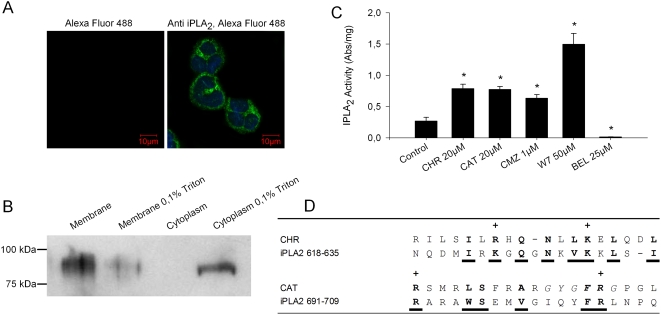
CHR and CAT stimulate iPLA2 activity.A) Fluorescence confocal microscopy of PMNs: Left, PMNs treated only with the secondary antibody (Alexa Fluo 488-conjugated donkey anti-rabbit IgG dilution 1∶2000). Right, PMNs stained with polyclonal anti-iPLA2 as primary antibody before Alexa Fluo 488 conjugated donkey anti-rabbit IgG. B) Western-blot analysis: The presence of a 82 kDa protein corresponding to iPLA2 was immunodetected in the membrane fraction obtained from PMNs. A comparable signal was obtained from the supernatant fraction of membranes treated with 0.1% Triton X-100. C) iPLA2 activity assay: Stimulation of iPLA2 activity after treatment by 20 µM CHR or 20 µM CAT for 30 min at 37°C and comparison with the effects of two CaM-binding factors (1 µM CMZ, 50 µM W7) and one iPLA2 inhibitor (25 µM BEL). Activity of iPLA2 is expressed as the absorbance (Abs/mg of protein) at λ405 nm. Results from two similar experiments, each performed in triplicate are presented as mean±S.E. * p<0.05, significance for difference from controls. D) Alignment of CHR and CAT sequences with two CaM-binding peptides of iPLA2. CHR sequence has been aligned with the iPLA2 CaM-binding motif aa 618 to aa 635 while the CAT sequence has been aligned with the iPLA2 CaM-binding motif (691–709). Corresponding homologous residues are in bold and underlined fonts.